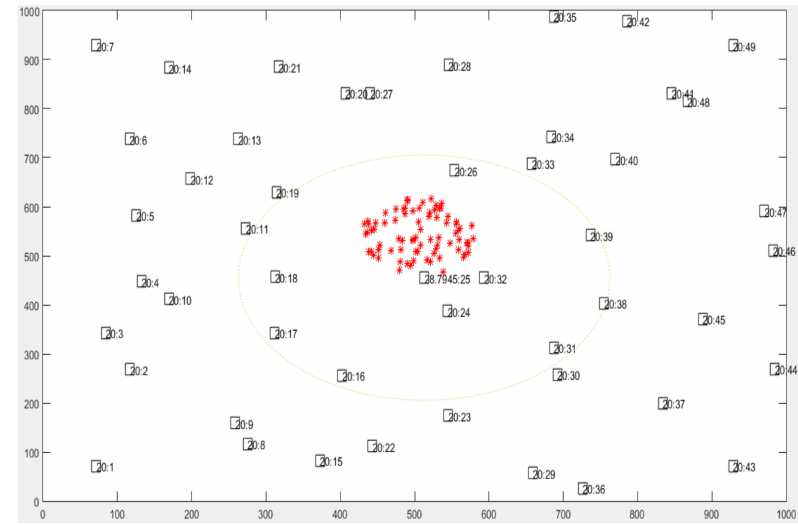
Figure 10. Simulation model of forest fire